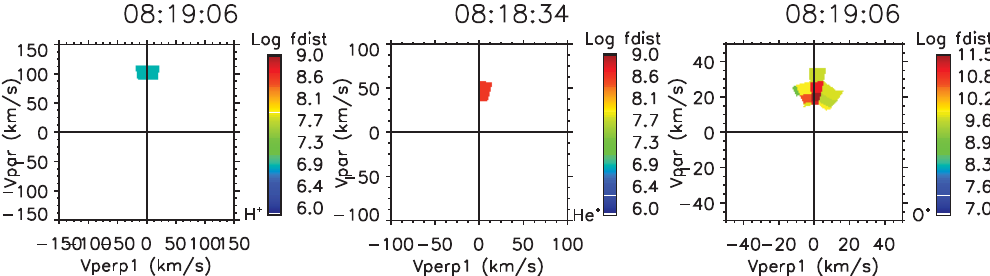
Figure 6. An example of velocity space distributions of O + ions measured on 31 October 2001, 19 March 2001 and 19 November 2001. These distributions are shown according to the spacecraft’s coordinate system and the velocity space is defined in terms of velocities parallel ( V par ) and perpendicular ( V perp ) to the magnetic field direction. The scales are ± 50kms − 1 . The beams were also observed by SC3 and